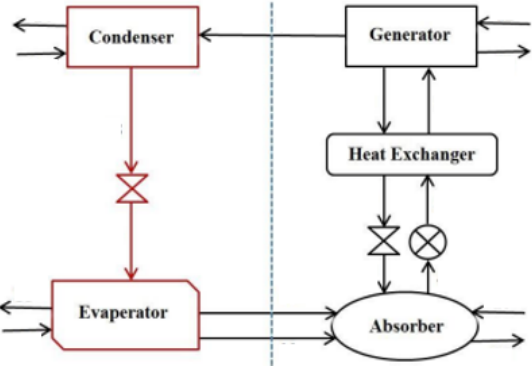
Figure 2. Single effect VAR cooling